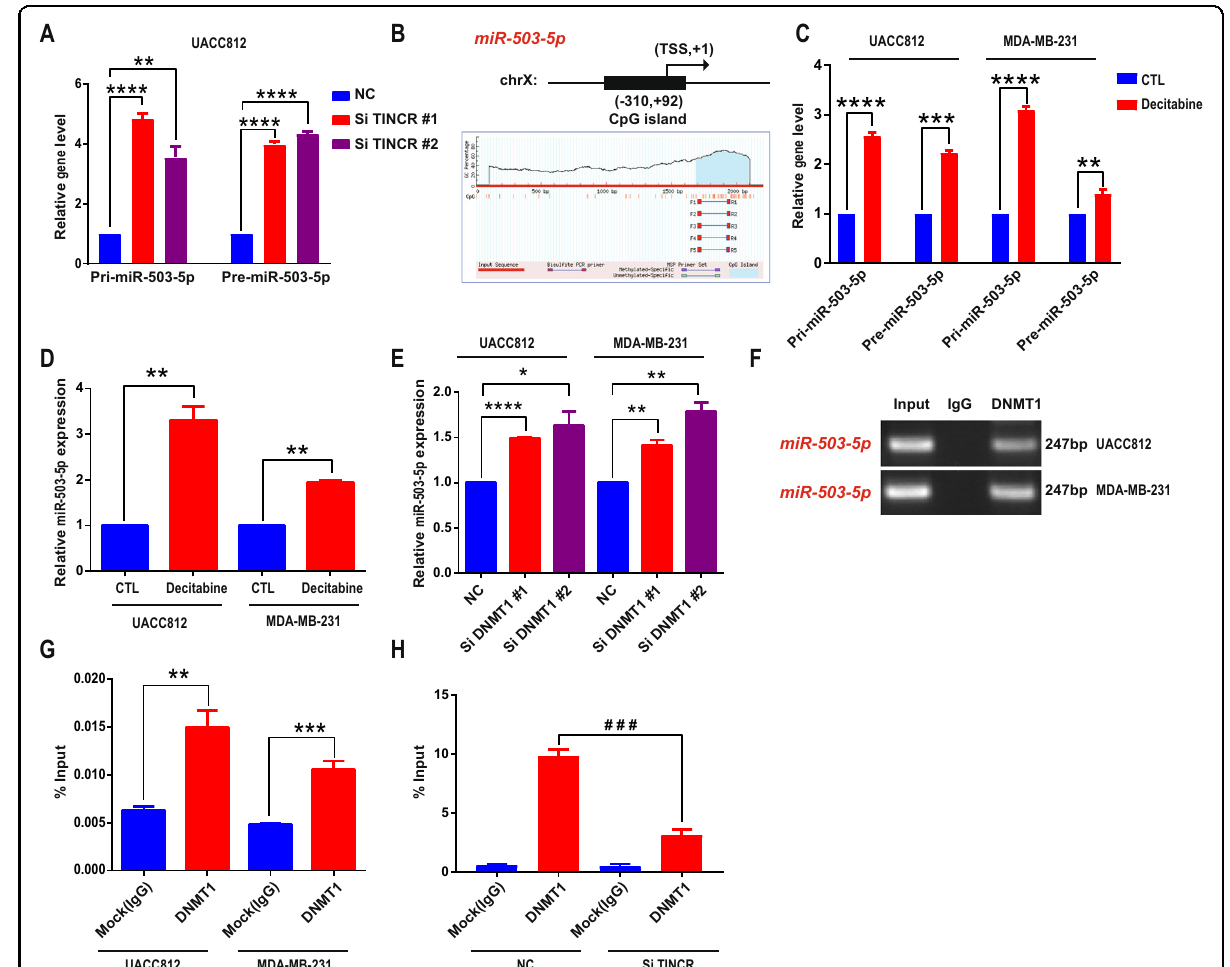
Fig. 6 TINCR recruits DNMT1 to miR-503-5p promoter to regulate miR-503-5p gene methylation. a TINCR knockdown increases Pri-MiR-503- 5p and Pre-MiR-503-5p expression in UACC 812 cells. b Schematic representation of predicted CpG island in miR-503-5p locus. CpG island located in the promoter region of miR-503-5p locus around the transcriptional start site (TSS, − 310 to + 92 bases; “ − ” : upstream of TSS; “ + ” : downstream of TSS). c Pri-MiR-503-5p and Pre-MiR-503-5p expression is upregulated in UACC 812 and MDA-MB-231 cells treated with decitabine (1 μ M) for 10 h. d MiR- 503-5p expression is upregulated in UACC-812 and MDA-MB-231 cells treated with decitabine (1 μ M) for 10 h. e miR-503-5p expression is upregulated in UACC 812 and MDA-MB-231 cells following DNMT1 knockdown. f ChIP assay results indicating that DNMT1 is enriched at miR-503-5p locus CpG islands in UACC 812 and MDA-MB-231 cells. g RIP-assay results showing higher enrichment of TINCR in DNMT1 group than IgG group in UACC 812 and MDA-MB-231 cells. IgG: negative control. h ChIP assay results indicating diminished enrichment of DNMT1 at the promoter of miR- 503-5p locus after TINCR knockdown. Data are presented as means from three independent experiments± S.D. * P < 0.05, ** P < 0.01, *** P < 0.001, **** P < 0.0001, ### P <